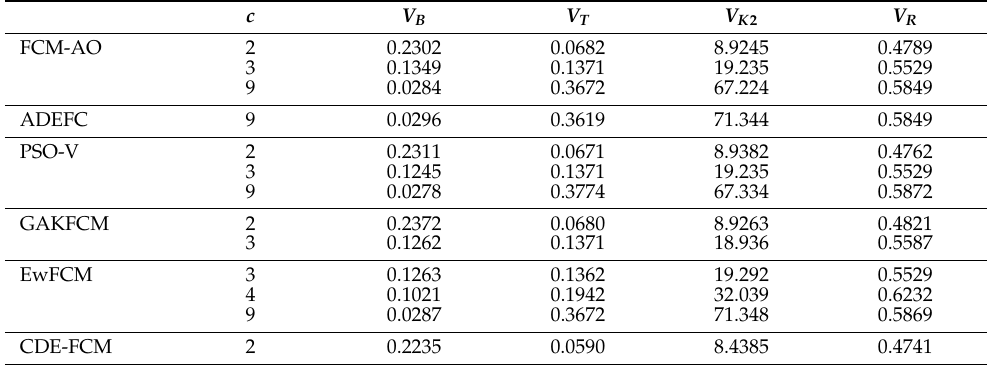
the naïve FCM-AO with random initializations took 22 iterations. Table 4. Performance of algorithms on Iris